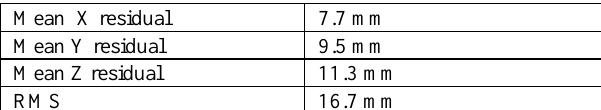
Table 2 - Residual on the Ground Control Points